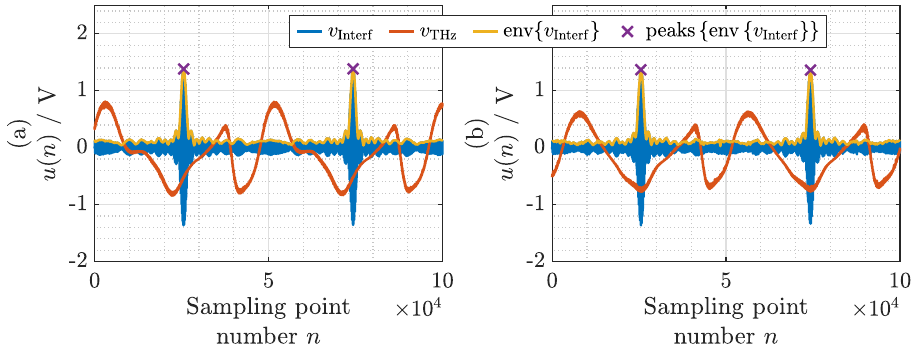
Figure 6. Signals measured with the oscilloscope ( a ) without and ( b ) with the COC sample. Blue lines: signals from the interferometer. Red lines: signals from the terahertz receiver. Yellow lines: envelope of the signal from the interferometer. Purple crosses: maxima of the envelope of the signal from the interferometer.